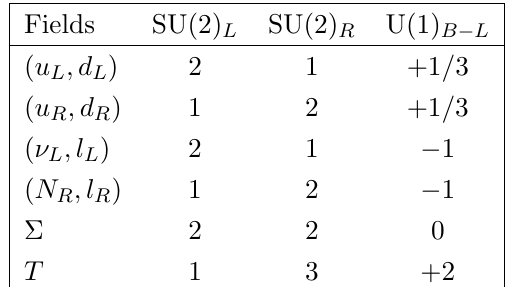
Table 1 . The particle contents and gauge charges of the SU(2) L (cid:2) SU(2) R (cid:2) U(1) B (cid:0) L Model [3]. The W 0 boson couples to the right-handed fermions with a strength g of the left-handed weak coupling. The W 0 boson can then be produced via q (cid:22) q 0 annihilation. The W 0 boson can mix with the standard model (SM) W boson via a mixing angle, say sin (cid:30) , so that the W 0 boson can decay into W Z and W H with a mixing-angle suppression, w and right-handed fermions. Previously, there was the 2 TeV W Z and W W anomaly